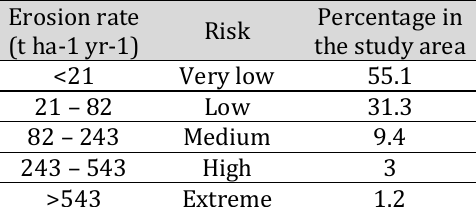
Table 2. Categorization of erosion risk